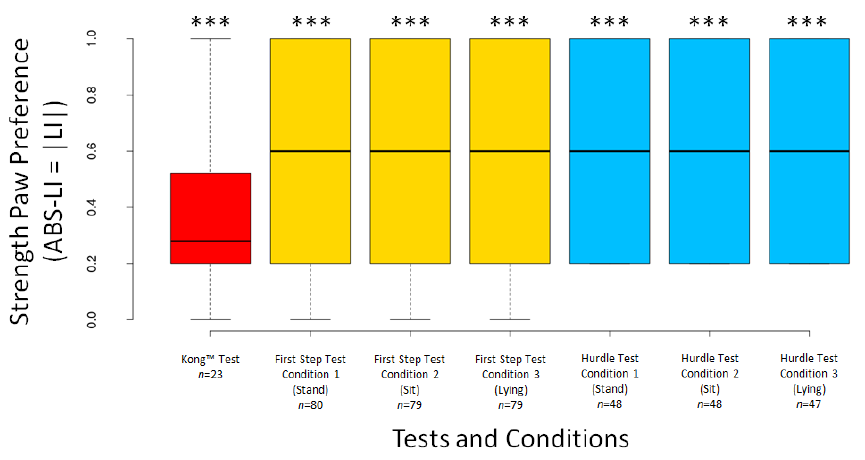
Figure 6. Boxplots showing dogs’ ABS–LI scores in the different tests and conditions. Asterisks indicate significant deviations from 0 (*** p <0.001).